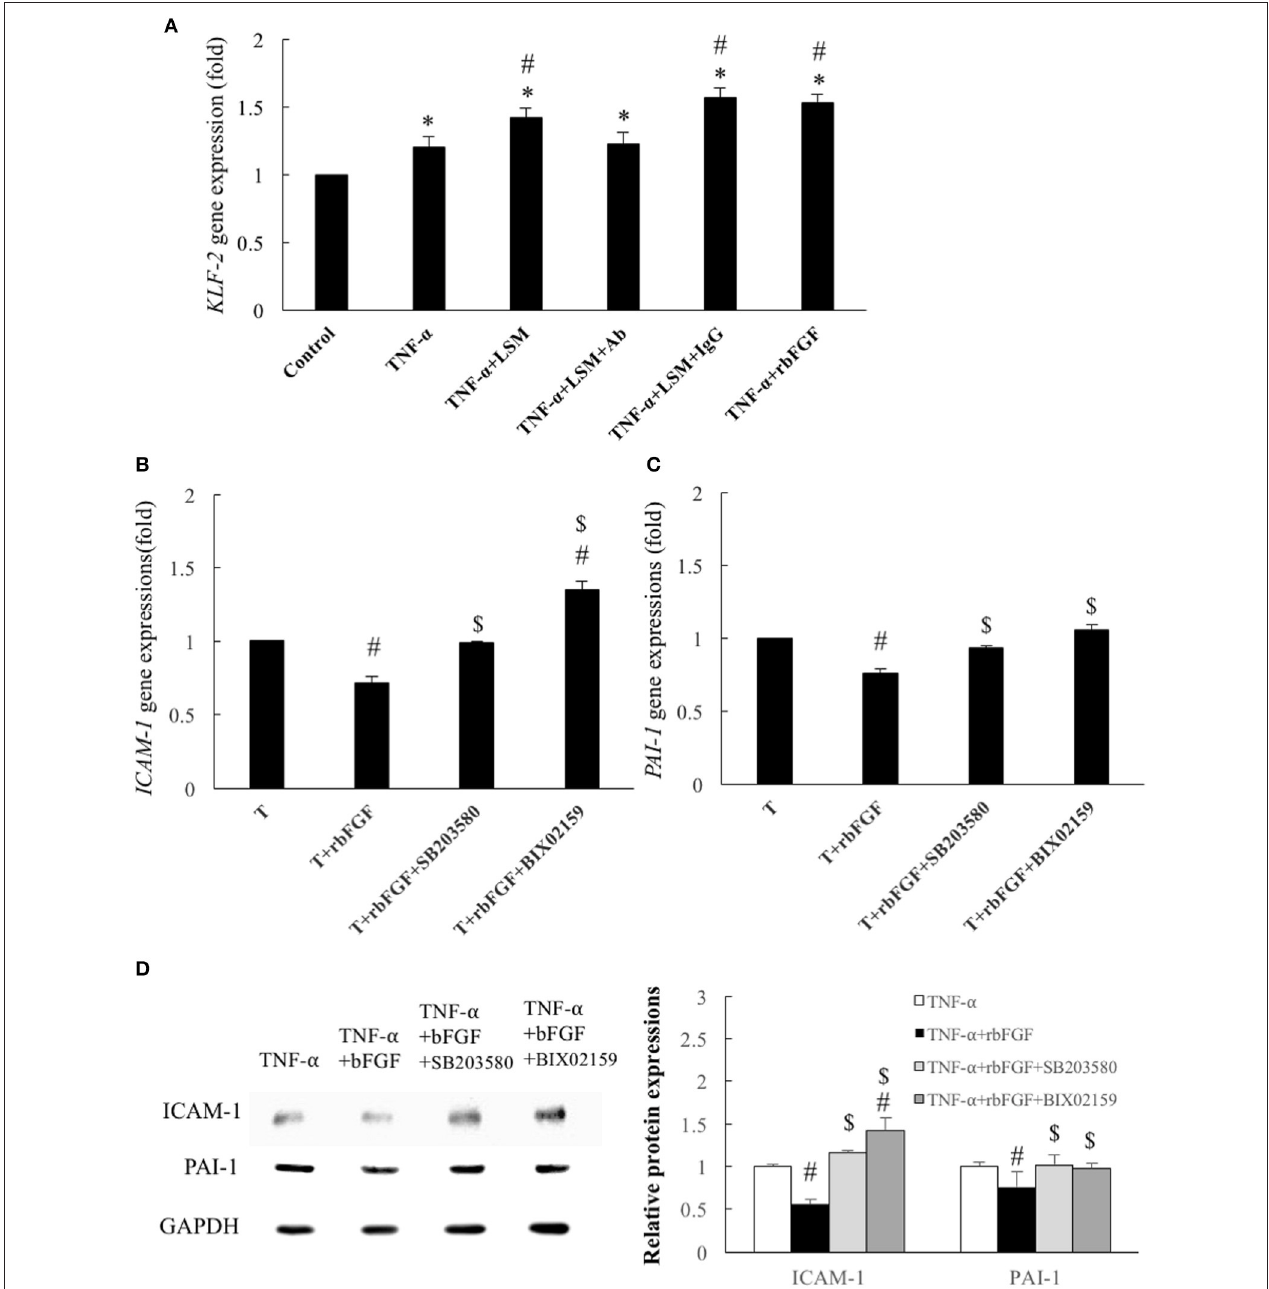
FIGURE 8 | Identification of cytoprotective mechanisms of bFGF. (A) Gene expression of KLF2 was increased significantly by 1.2-fold by TNF- α , compared to the control group. In the TNF- α + LSM, TNF- α + LSM + IgG, and TNF- α + rbFGF groups, the gene expression of KLF2 was further enhanced by 1.41-, 1.57-, and 1.53- fold compared to the control groups. The KLF2 level in the TNF- α + LSM + Ab group was not significantly different from that in the TNF- α group. Data are expressed as the mean ± S.E.M. ( n = 4). * p < 0.05 and #p < 0.05 indicate a significant different relative to the control group and TNF- α group, respectively. (B) Compared to the TNF- α group, ICAM-1 expression was significantly decreased to 0.71-fold in the TNF- α + bFGF group. However, the anti-inflammatory effect of bFGF on ICAM-1 expression was reversed to 0.99- and 1.35-fold compared to in the TNF- α group by pretreatment with SB203580 (10 µ M) and BIX02189 (10 µ M), respectively. (C) Compared to the TNF- α group, the PAI-1 expression level was significantly decreased to 0.76-fold in the TNF- α + bFGF group. However, the anti-thrombotic effect of bFGF on PAI-1 gene expression was reversed to 0.93- and 1.05-fold compared to in the TNF- α group by pretreatment with SB203580 and BIX02189, respectively. T: TNF- α (B,C) Data are expressed as the mean ± S.E.M. ( n = 4). # p < 0.05 indicates a significant difference relative to the TNF- α group and $ p < 0.05 indicates a significant difference relative to the TNF- α + rbFGF group. (D) Compared with the TNF- α group, ICAM-1 and PAI-1 protein levels were significantly decreased in the TNF- α + rbFGF group and were reverted by pretreatment with SB203580 and BIX02189, respectively ( n = 3). # p < 0.05 indicates a significant difference relative to the TNF- α group and $ p < 0.05 indicates a significant difference relative to the TNF- α + rbFGF group.